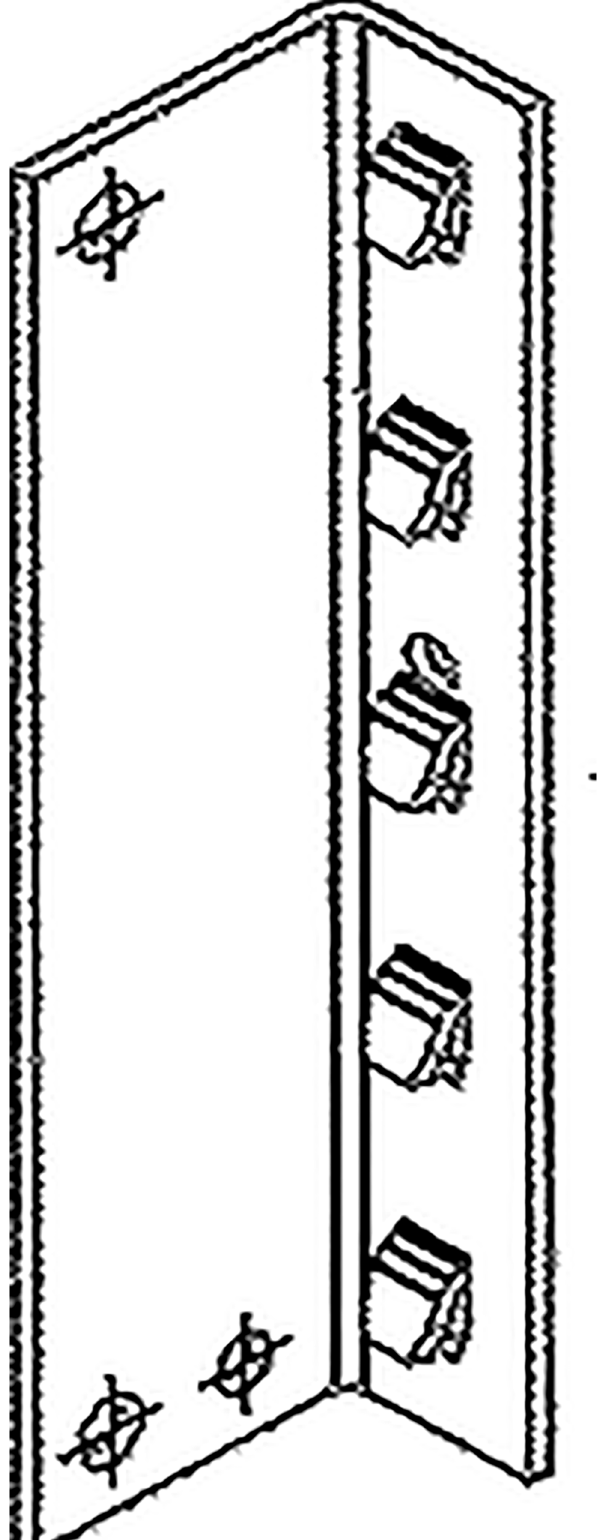
Fig 3. Cross-section of the beam end